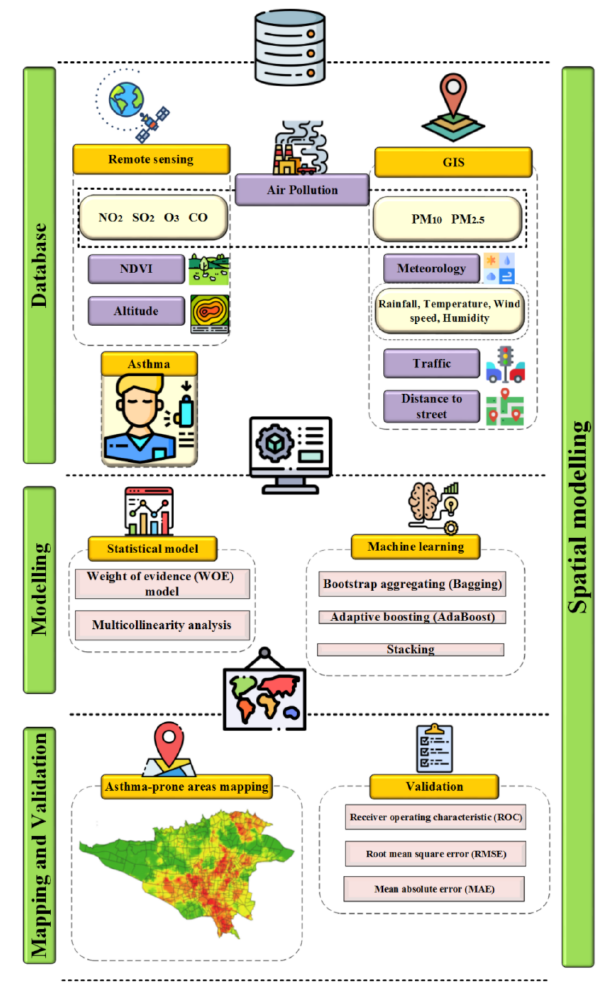
Figure 1. Research